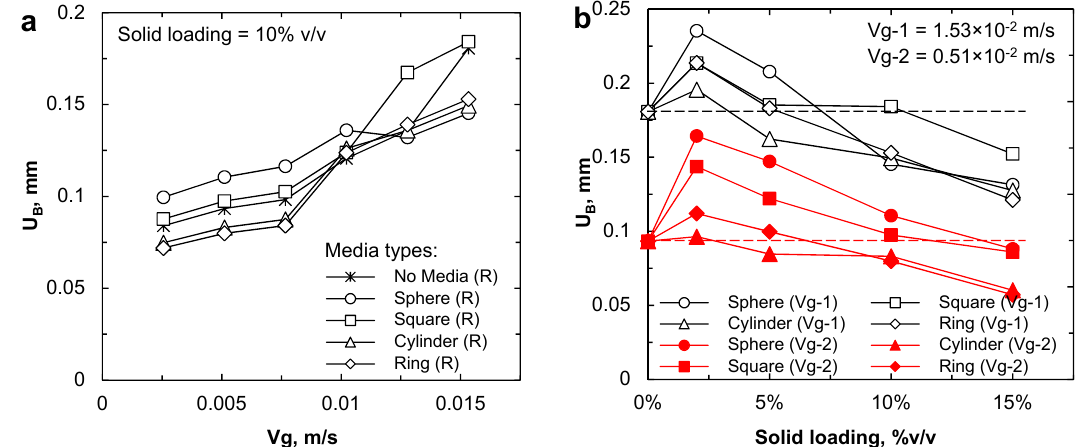
Figure 5. Bubble rising velocity (U B ) in the riser compartment of ALR for each solid media type with: ( a ) superficial gas velocity (Vg) and ( b ) solid